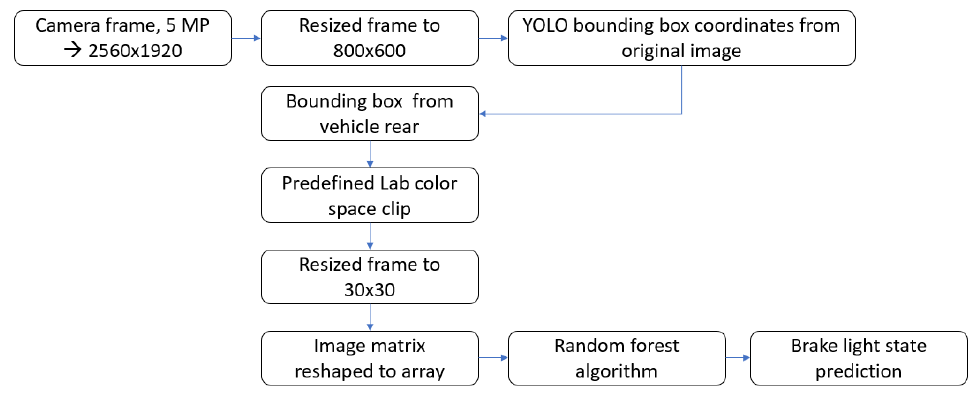
Figure 3. Workflow for the algorithm.